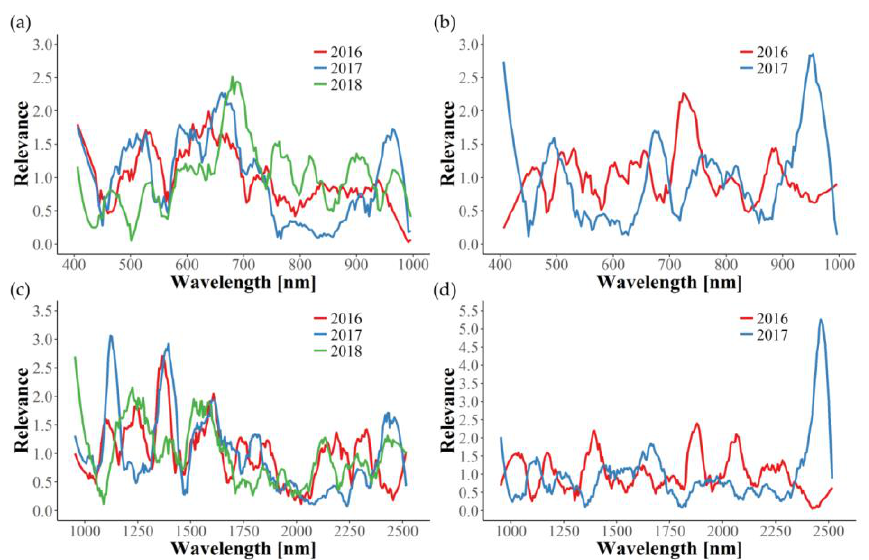
Figure A1. Spectral relevance profiles for VNIR ( a , b ) and SWIR ( c , d ) in three consecutive years regarding white ( a , c ) and red ( b , d ) cultivars infected with GLRaV-3.